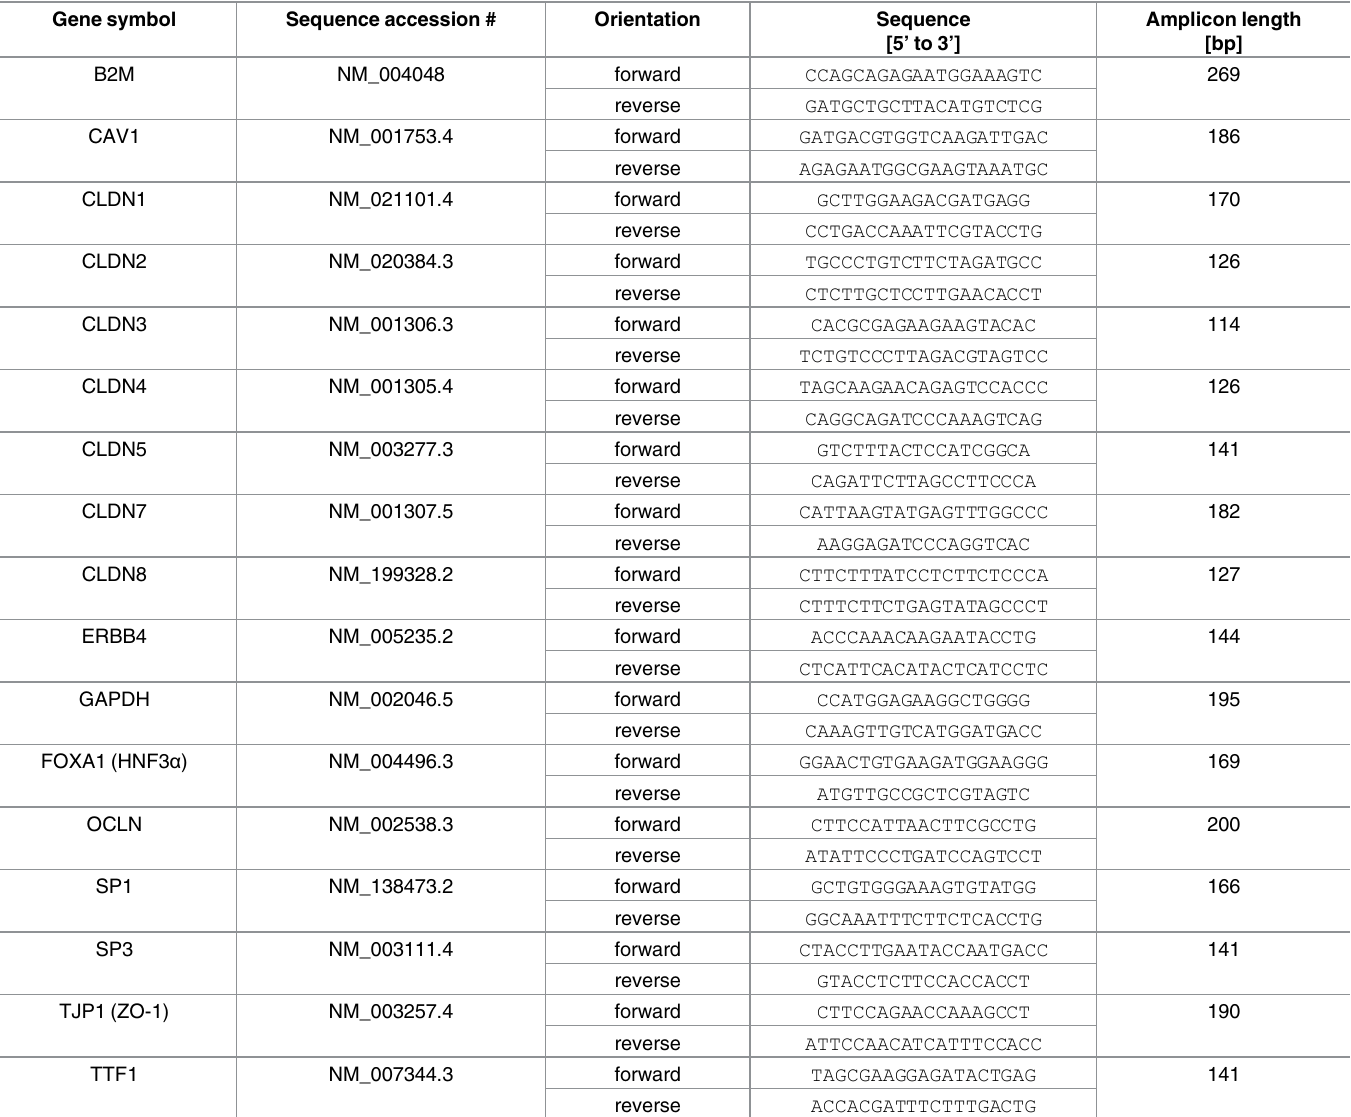
Table 1. Primers for